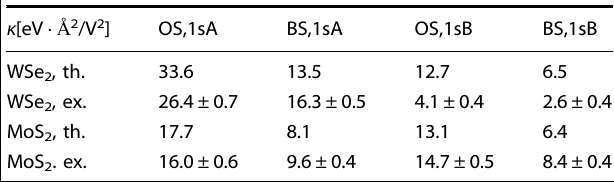
Table 2. The coef fi cient κ (cid:4) Δ E ± and experimentally (ex.) for OS ( Δ E þ 1sA(1sB) excitons in WSe 2 and MoS 2